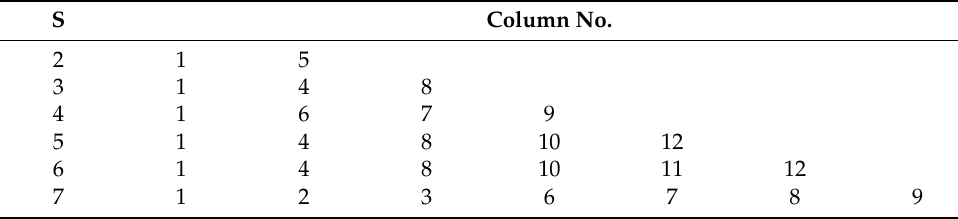
Table 4. Use table of U 31 (31 12 ).